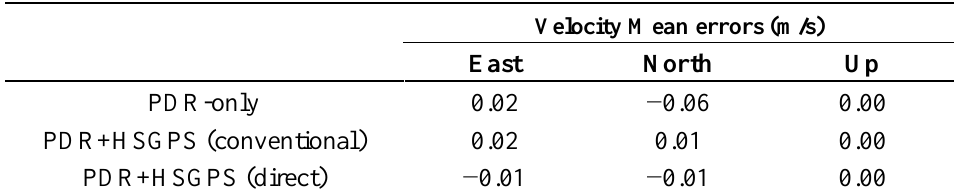
Table 4. Mean velocity